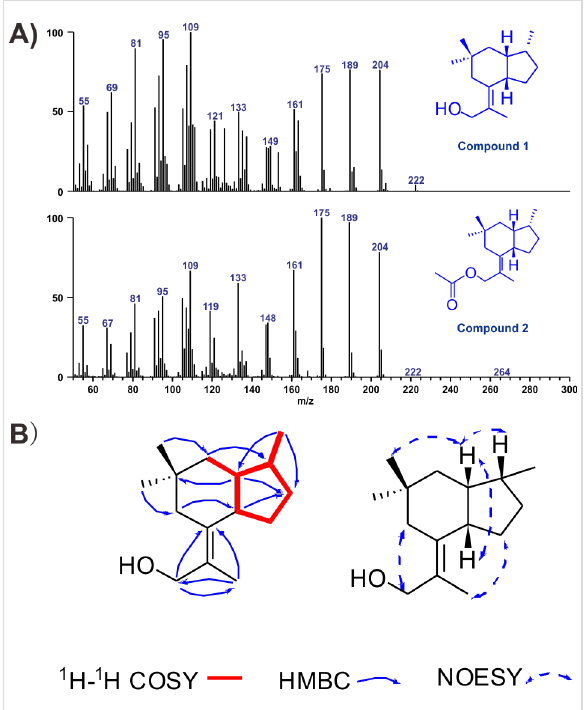
Figure 4: Characterisation of Tvi09626 products. (A) Mass spectra of compound 1 at t R = 13.46 min with m / z 222 and compound 2 at t R = 14.53 min with m / z 264. (B) COSY, HMBC and NOESY correla- tions for compound 1 .